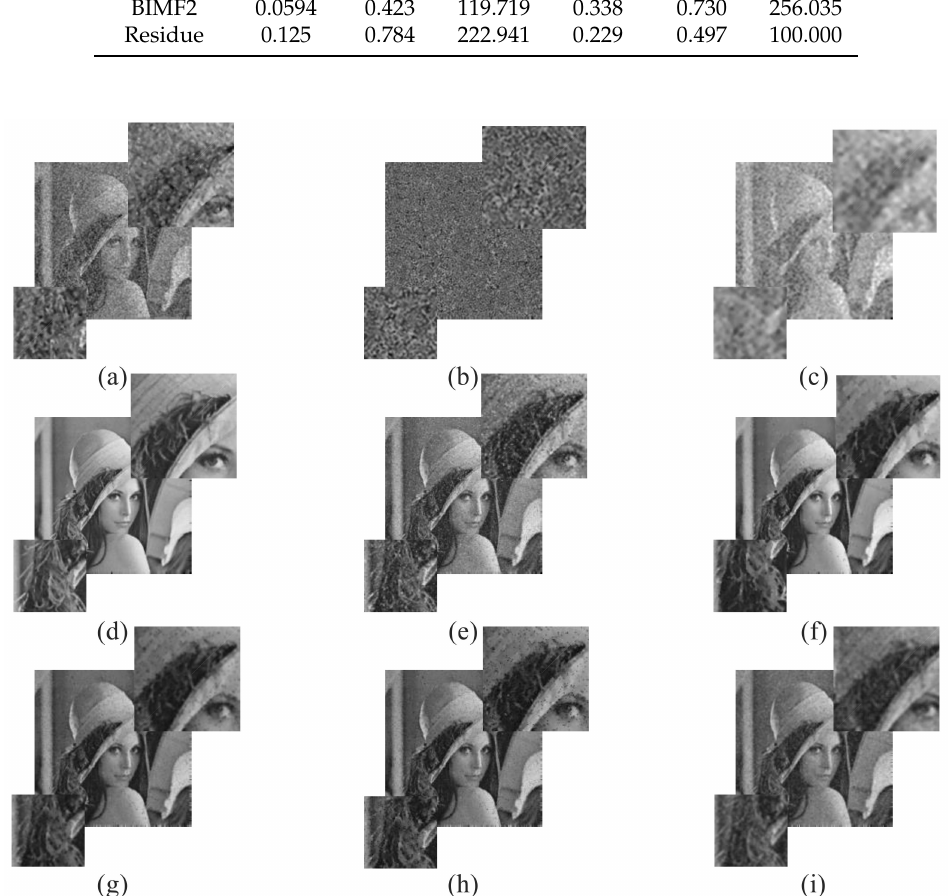
Figure 7. Lena image: ( a – c ) the noise-suppression BIMF 1 to 2 and the residue, ( d ) The proposed BEMD- GWO-pulse-coupled neural network (PCNN) reconstruction image, ( e ) median filter, ( f ) PSO-PCNN method, ( g ) GACA-PCNN, ( h ) conventional random parameters (COR)-PCNN, ( i ) tBEMD-non-linear complex diffusion process